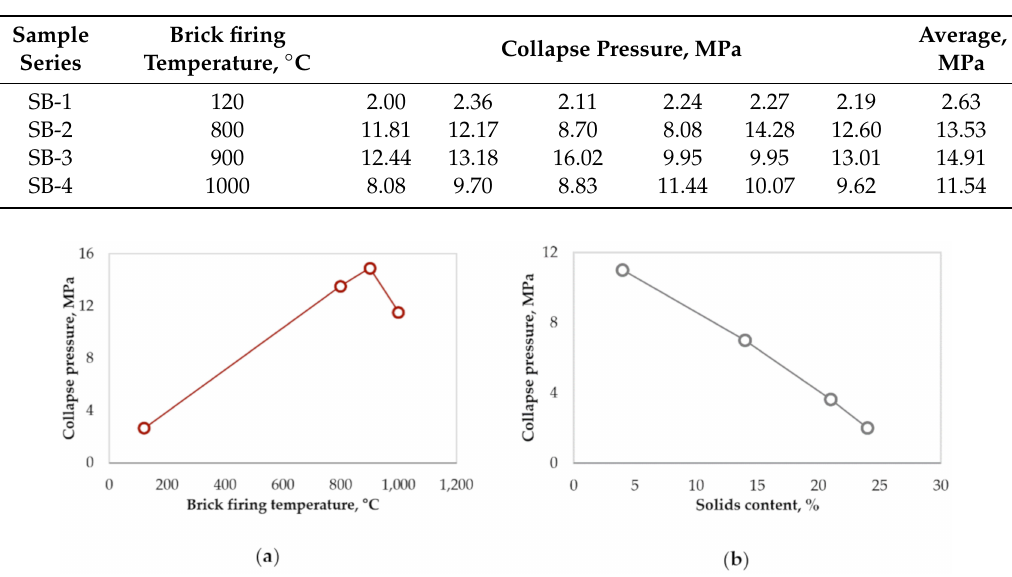
Table 2. Measured collapse pressure values by subjecting four saponite brick sample series (SB) to the controlled compressive displacement along a single axis.